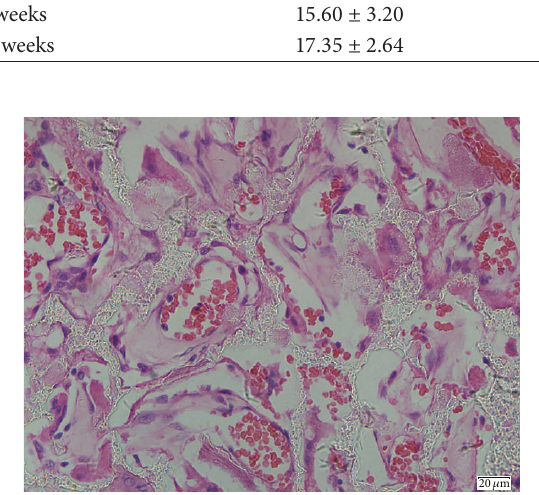
Figure 2: Hematoxylin and eosin (HE) staining of specimens 10 weeks after implantation (magnification × 400) showed the tube architecture of the newly formed vessels.